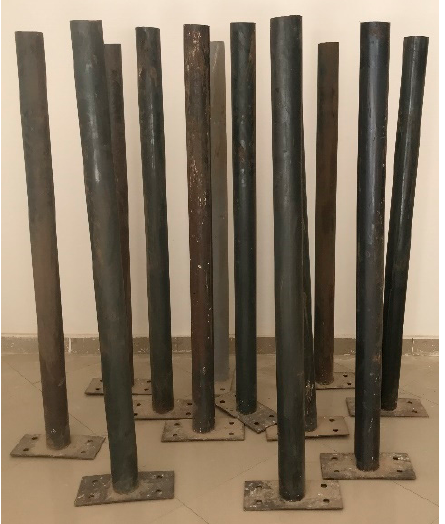
Figure 1. Specimen steel